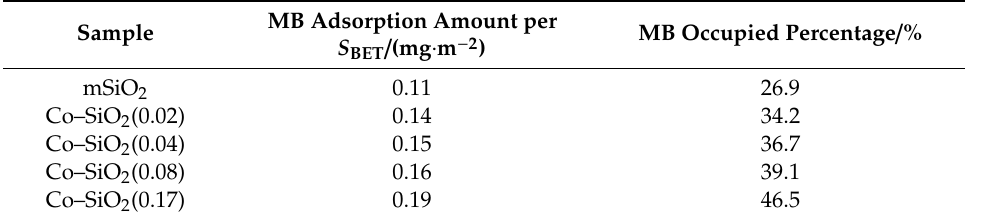
Table 2. Theoretically calculated results for the adsorbed MB molecules occupied on the surface of the